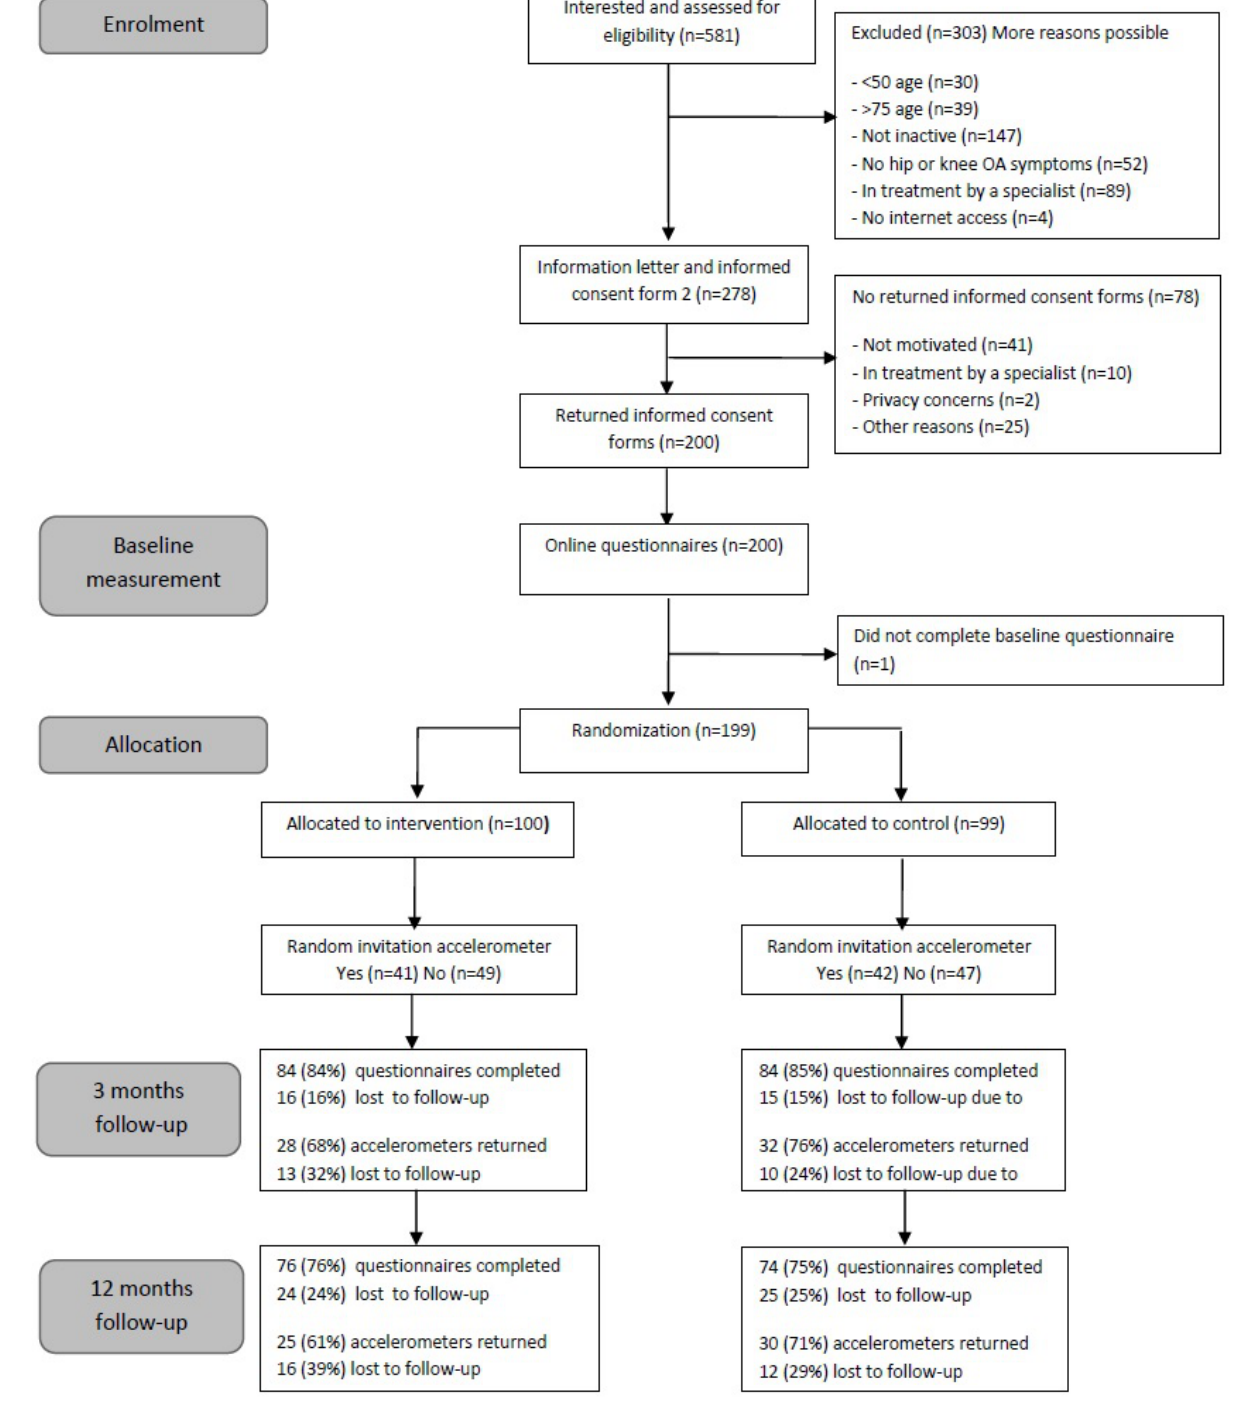
Figure 2. Flow of participants throughout the